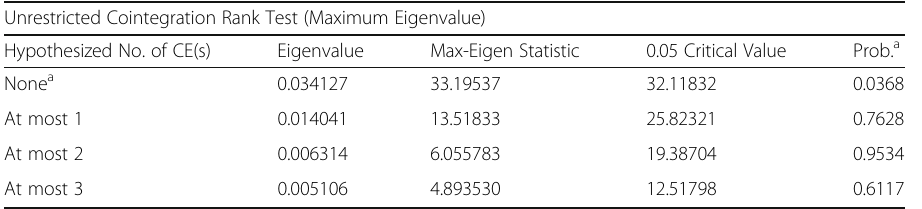
Table 1 Cointegrating relationship between the Cryptocurrencies Unrestricted Cointegration Rank Test (Maximum Eigenvalue) Hypothesized No. of CE(s) Eigenvalue Max-Eigen Statistic None a 0.034127 At most 1 0.014041 At most 2 At most 3 Max-eigenvalue test indicates 1 cointegrating eqn(s) at the 0.05 level a denotes rejection of the hypothesis at the 0.05